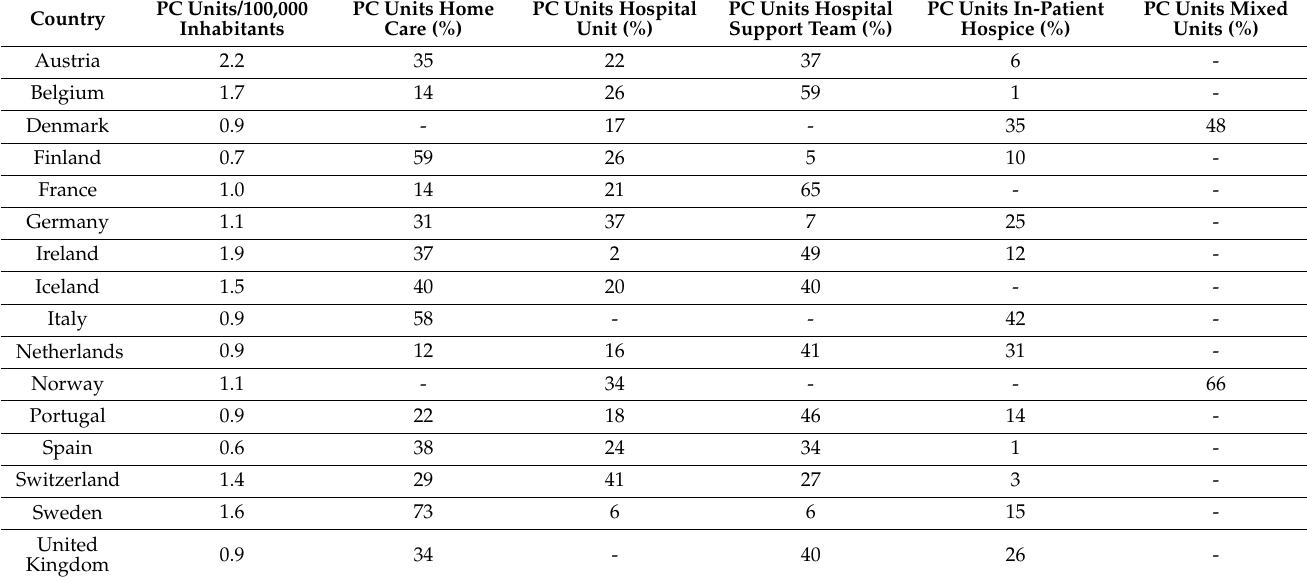
Table 1. Data from the EAPC Atlas of Palliative Care in Europe 2019 depicting numbers/100,000 inhabitants and different proportions of palliative care (PC) units in different western European